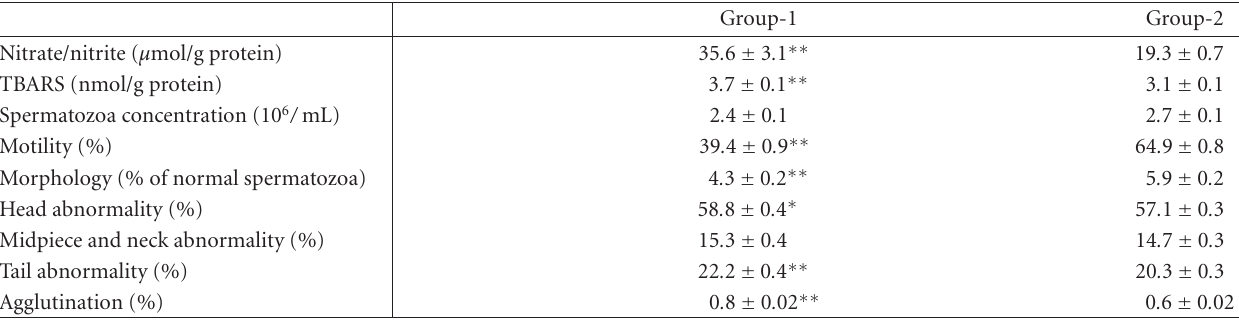
Table 1: Testicular tissue nitrate/nitrite and TBARS levels and semen analysis results in study (Group-1) and control (Group-2) groups (Mean ±